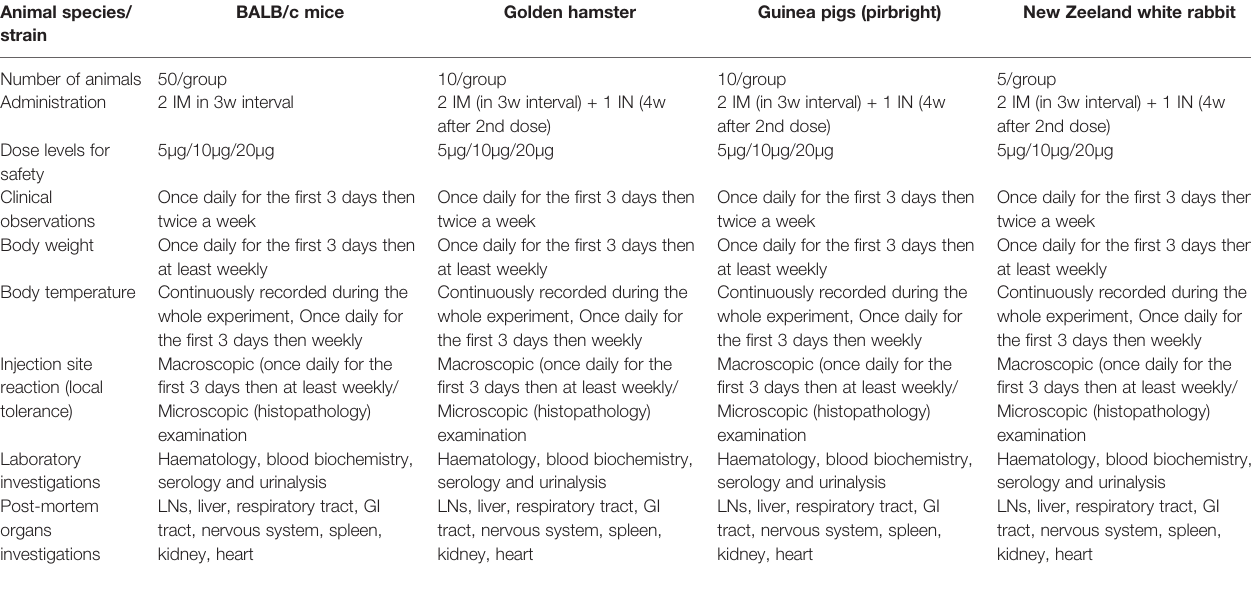
TABLE 1 | The detail of animal studies for evaluation of safety pharmacology, including toxicity, toxicity upon repeated doses and pyrogenicity assessment, performed in accordance with the ICH M3 guidelines. Animal species/